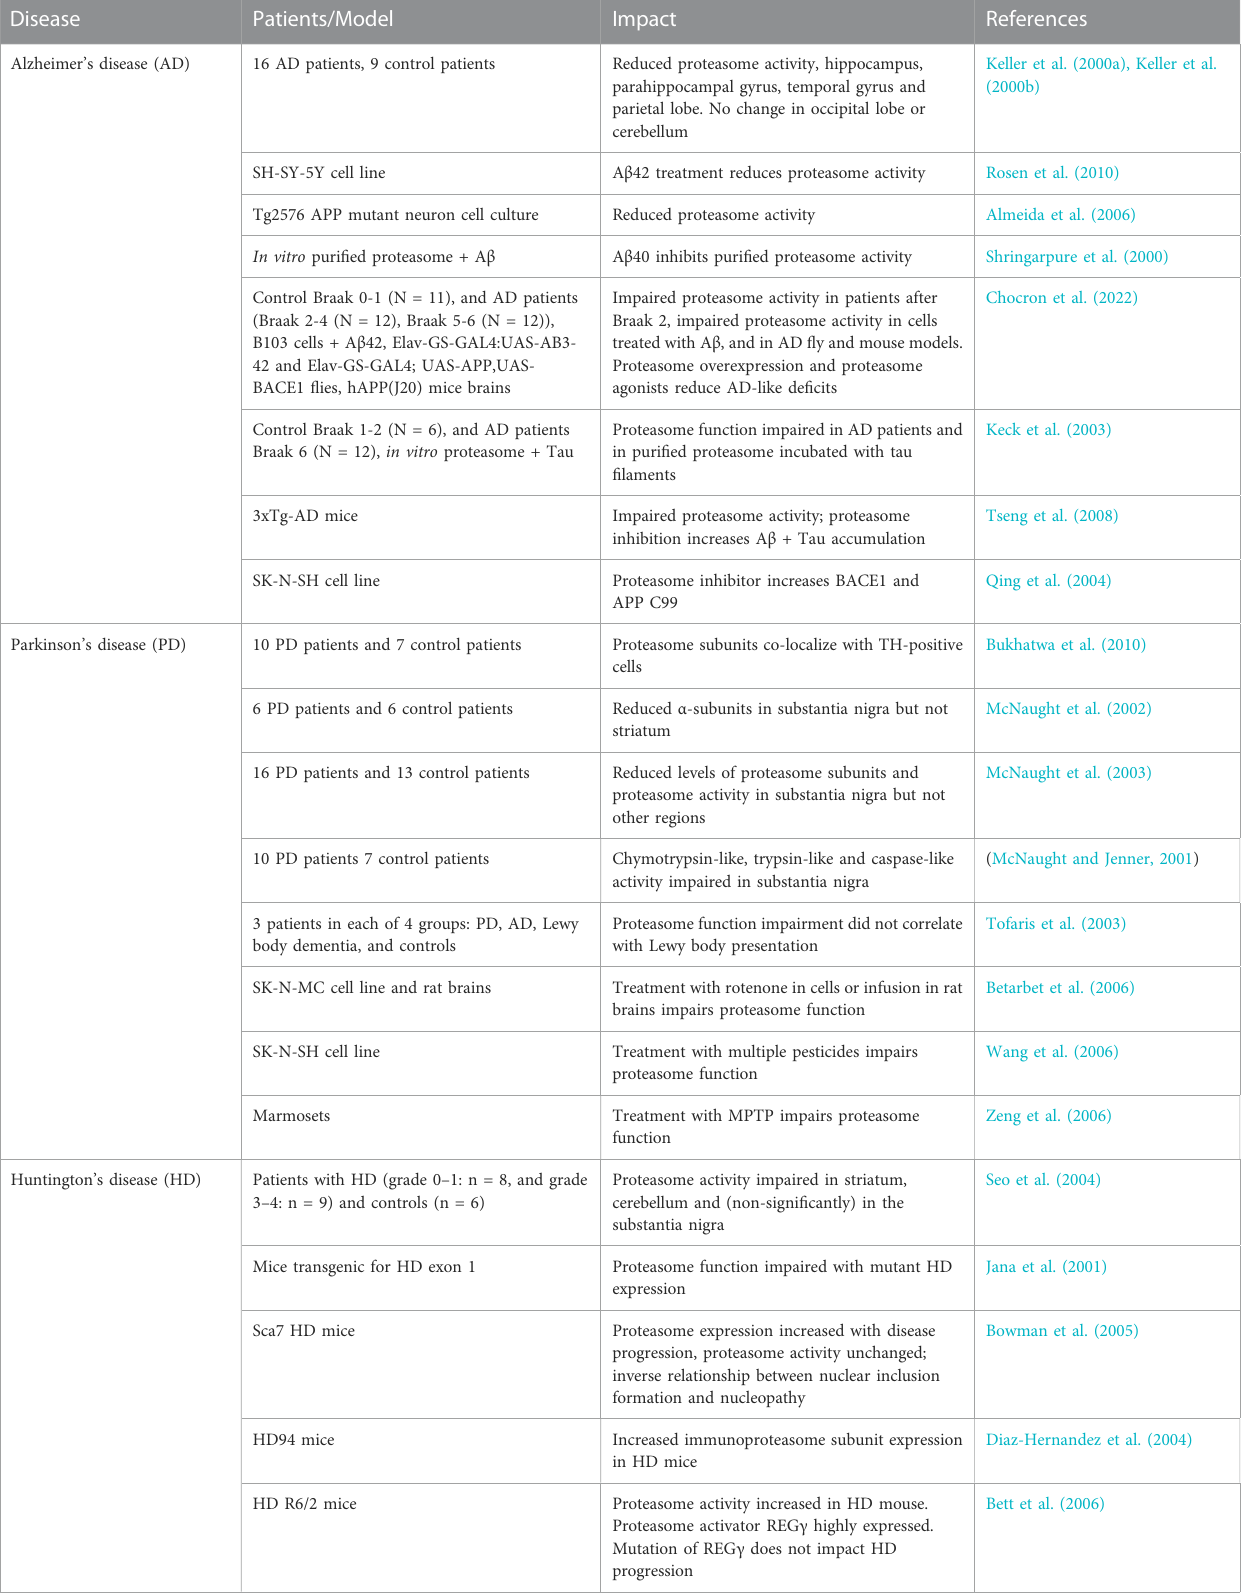
TABLE 1 Studies examining proteasome function in patients with neurodegenerative diseases or animal/cell culture models.